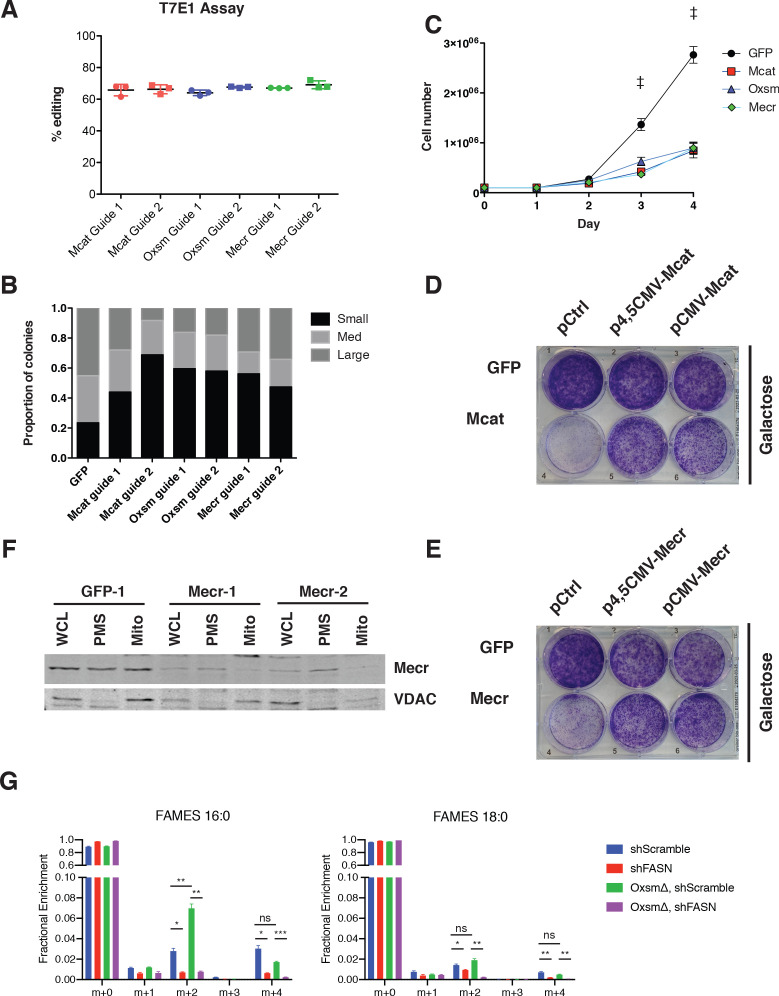
mtFAS is required for growth of cultured skeletal myoblasts but does not significantly contribute to cellular fatty acids.(A) Quantification of T7E1 assay for editing efficiency in bulk transfected C2C12 cells with sgRNAs targeting the indicated mtFAS genes. (B) Quantification of single cell clone colony size 7 days after single cell sort. Small clones = <150 cells, Med = 150–500 cells, Large = >500 cells. (C) Cells were plated at 100,000 cells/plate in 10 cm dishes and counted every 24 hr. #=p < 0.01, all groups compared with control, †=p < 0.001, all groups compared with control, error bars SEM. (D-E) GFP control, Mcat, and Mecr mutant cells were infected with retroviral control plasmid (pCtrl) or plasmids expressing Mcat (D) or Mecr (E) off the truncated (Δ4,5CMV) or full CMV promoters as indicated. Cells were plated at equal densities in normal growth medium without glucose and with 10 mM galactose and grown for 4 days, then stained with crystal violet. (F) Sub-cellular fractionation of Mecr mutant cell lines and control. Whole cell lysate (WCL), post mitochondrial supernatant (PMS), and mitochondrial lysate (Mito) was isolated from each cell line indicated, normalized for total protein via BCA assay, and immunoblotted for Mecr or VDAC as a mitochondrial marker control. (G) Control (GFP) or Oxsm mutant (OxsmΔ) cells were stably infected with shRNA targeting FASN (shFASN) or control (shScramble) then incubated with U13C-glucose for one doubling were harvested, lipids extracted and saponified, and analyzed via FAMES analysis. Shown are quantitation of c16:0 and c18:0 fatty acids. ns = non significant, *=p < 0.05, #=p < 0.01, †=p < 0.001, error bars are SEM.